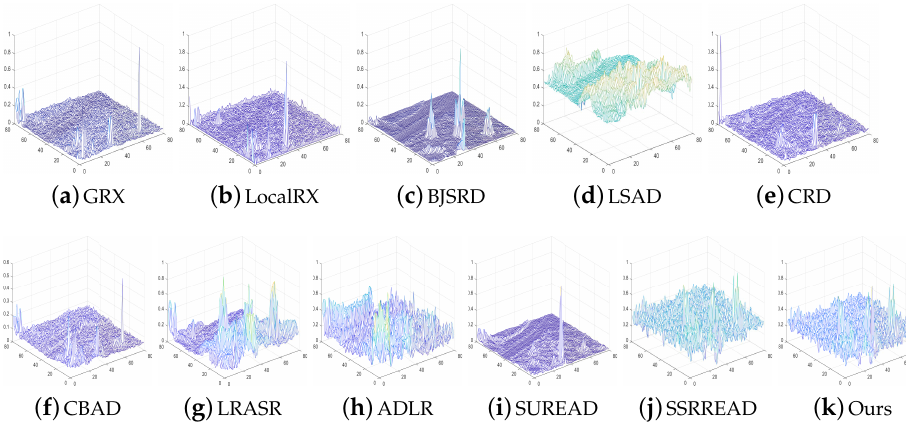
Figure 17. 3-D mesh of the detection algorithms for the Sandiego80